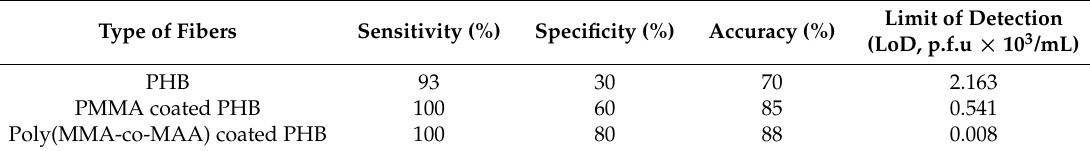
Table 1. Sensitivity, specificity, accuracy, and limit of detection (LoD) for coated and uncoated electrospun PHB fibers.